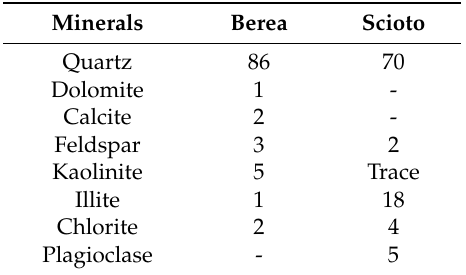
Table 4. Mineral composition of the core samples.